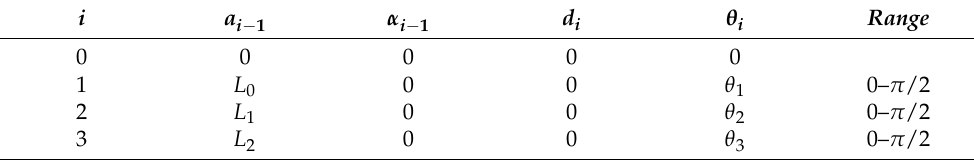
Table 1. Parameters and ranges of the